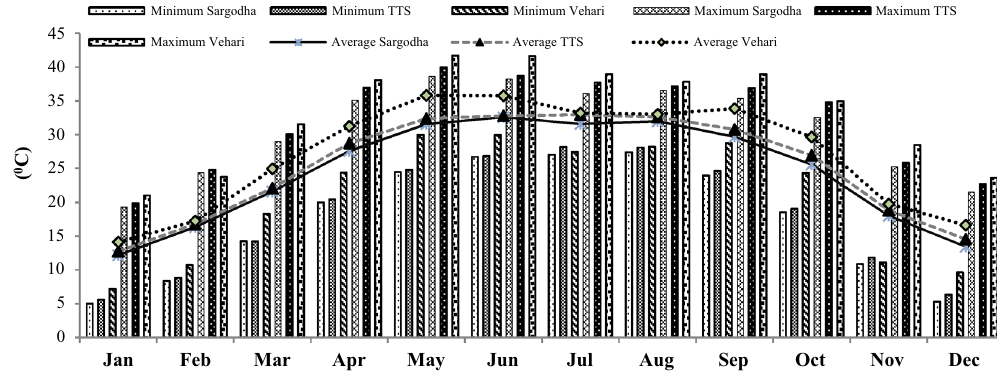
Figure 1. Temperature data of three districts.